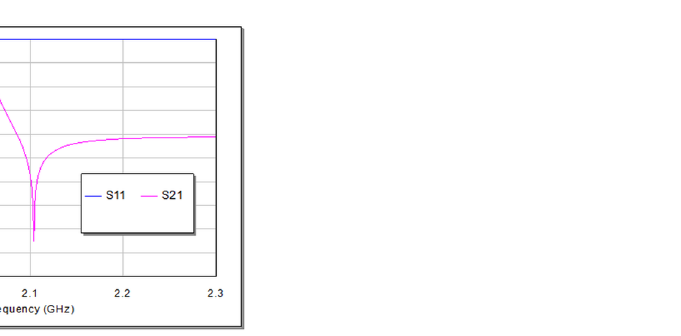
Fig 8. In-band frequency response for microstrip bandpass filter shown in Fig 4.